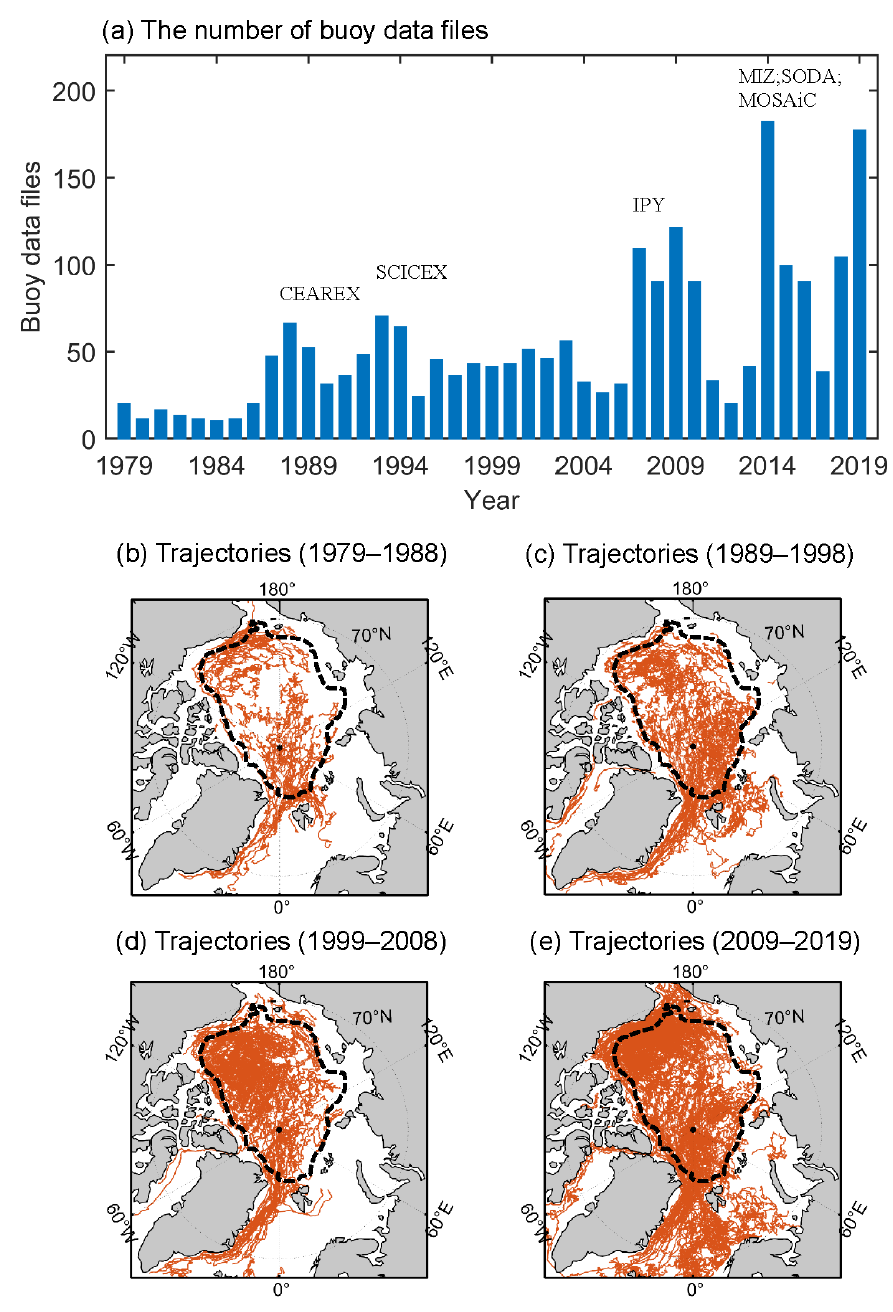
Figure 1. ( a ) The number of buoy data files available in this study from IABP between 1979 and 2019. Relevant large international programs are marked at the corresponding time points, including the Coordinated Eastern Arctic Experiment (CEAREX, 1988–1989); Submarine Arctic Science Program (SCICEX, 1993–); International Polar Year (IPY, 2007–2008); Marginal Ice Zone observational